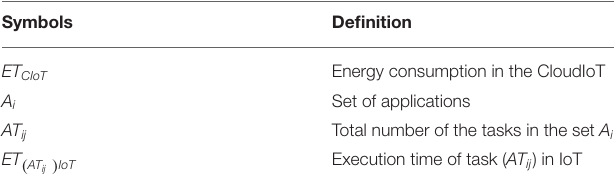
TABLE 1 | List of symbols that are